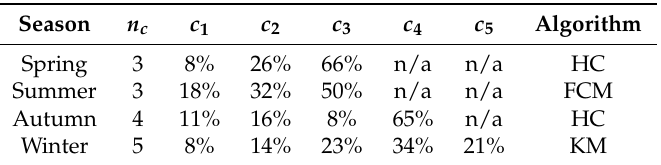
Table 4. Percentage of consumers in the clusters c 1 – c 5 (where n/a is not applicable) for each season and respective